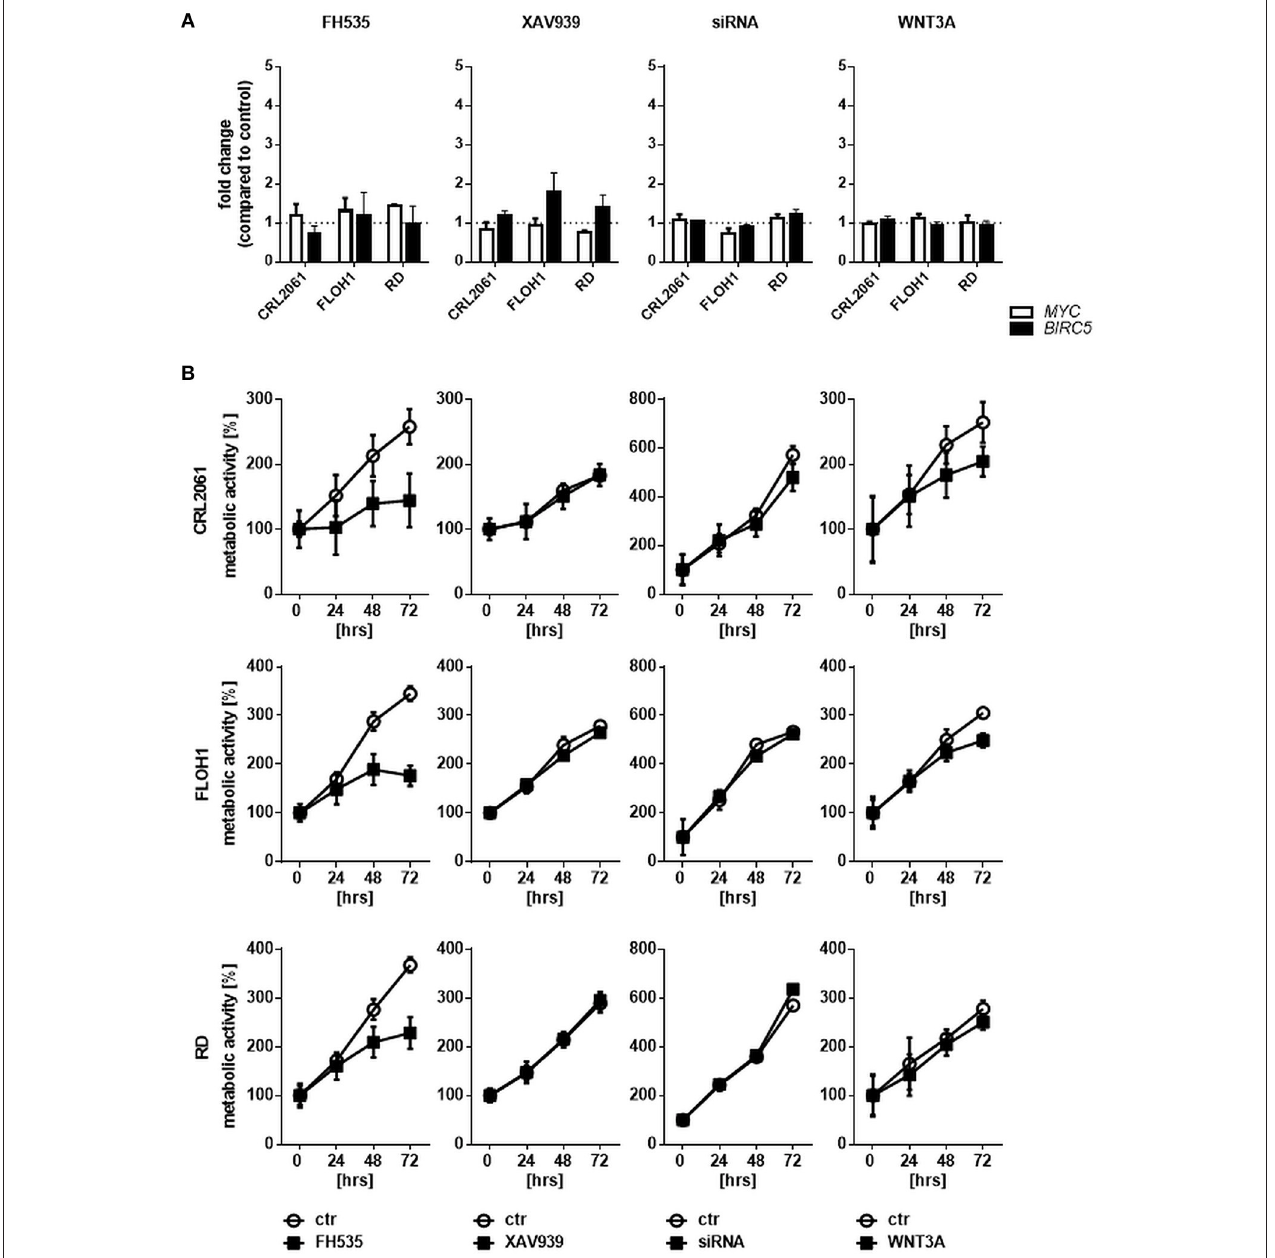
FIGURE 3 | Effects of FH535, XAV939, ß-catenin siRNA, or WNT3A on proliferation of RMS cell lines. (A) qRT-PCR of the ß-catenin-target genes MYC (white bars) and BIRC5 (black bars) after incubation with FH535 (40 µ M), XAV939 (16 µ M), ß-catenin siRNA, or WNT3A conditioned medium for 48h. GAPDH was used for normalization. Shown is the mean and SEM of three independent experiments measured in duplicates and compared to the solvent control. (B) represents MTT test to examine the influence of 40 µ M FH535, 16 µ M XAV939, ß-catenin siRNA, or conditioned WNT3A Medium on metabolic activity of the ARMS cell lines CRL2061 and FLOH1 and the ERMS cell line RD over 72h. DMSO and scrambled siRNA served as control (ctr). The graphs show one out of three experiments, measured in triplicates.